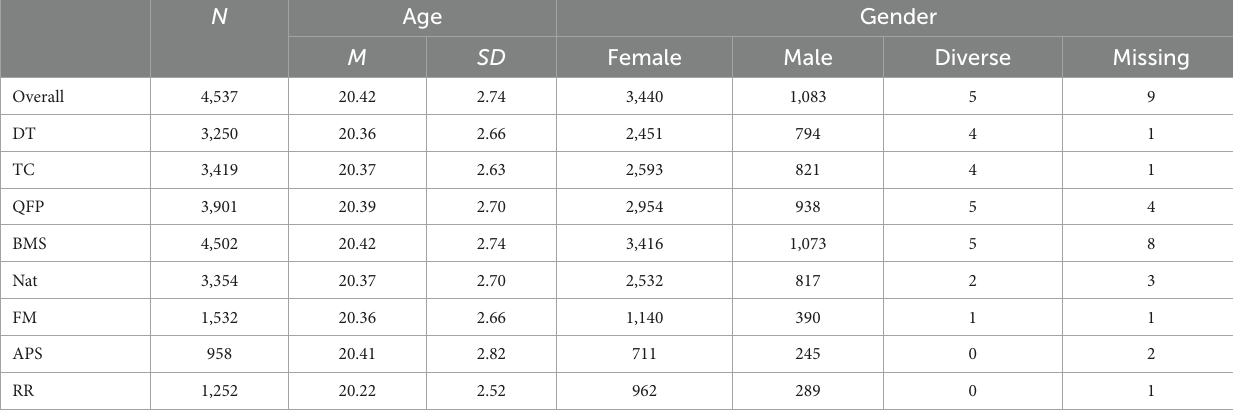
TABLE 1 Demographic variables and sample sizes for all